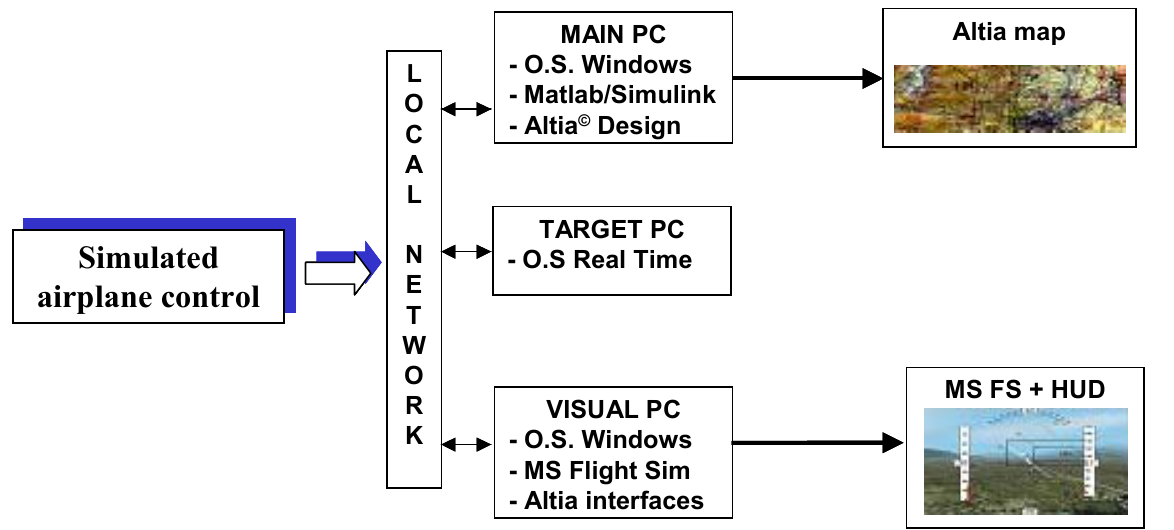
Fig 7. Configuration of the system for RCS integrated with Mini-UAV numerical model